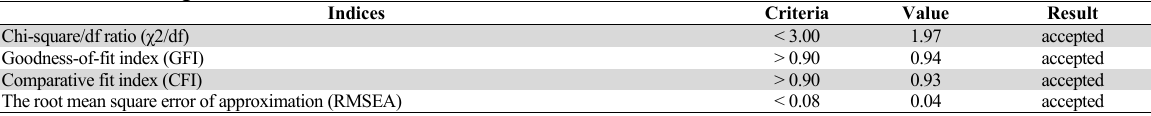
Measurement model goodness-of-fit Indices Criteria